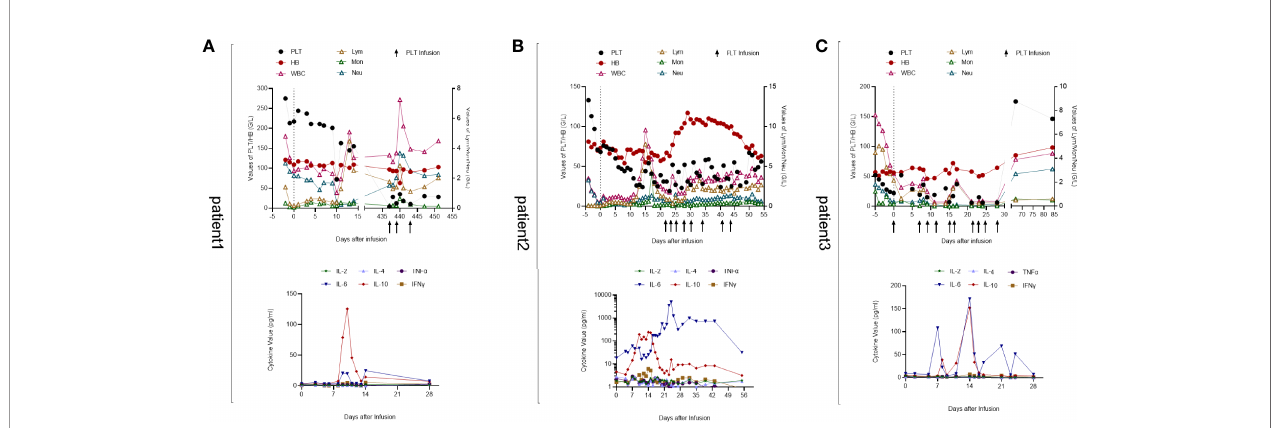
FIGURE 2 | Peripheral blood cell counts and cytokine levels of 3 patients. (A) Patient 1. Early cytopenia occurred on day 10 and recovered soon while isolated thrombocytopenia developed later on day 437. The IL-10 level peaked on day 10 and the IL-6 level fl uctuated in accordance with IL-10. (B) Patient 2. Pancytopenia developed after CAR-T cell infusion. His hemoglobin and leukocyte returned to normal levels 1 month later but thrombocytopenia remained with platelet transfusion necessary. His cytokine levels were signi fi cantly higher than those of the other two patients, which may be associated with his gastrointestinal bleeding and cardiovascular disorders. (C) Patient 3. His WBC count declined after lymphodepletion chemotherapy. Severe leukopenia and thrombocytopenia occurred 2 weeks after CAR-T cell infusion with blood transfusion inef fi cacious. At follow-up on day 67, his PLT and WBC returned to normal levels with hemoglobin elevated obviously. IL-6 and IL-10 levels were unstable and fl uctuated along with each